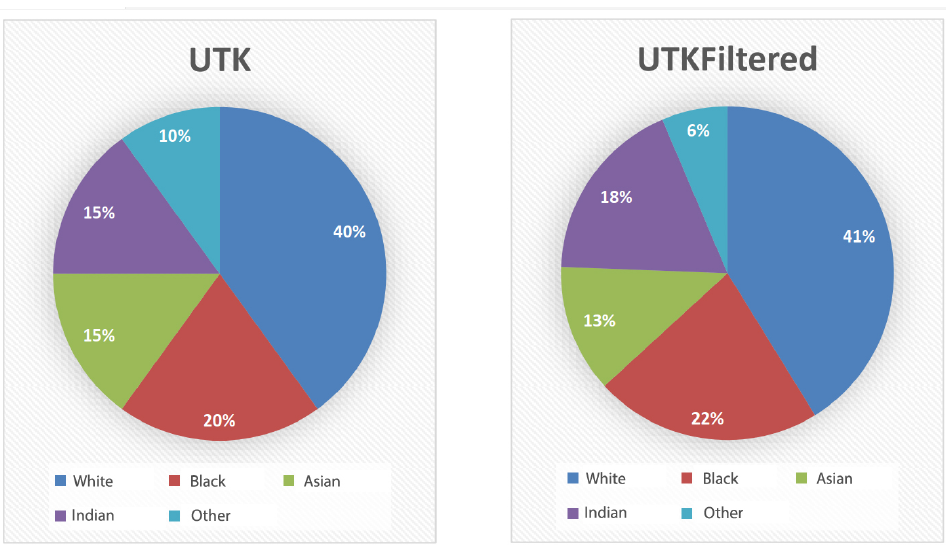
Figure 5. Representation of ethnicities in UTKFace ( left ) and UTKFace filtered ( right ).